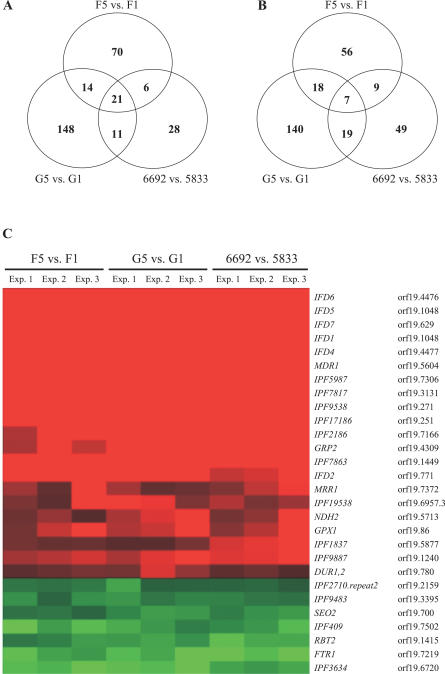
Identification of Genes that Are Differentially Expressed in MDR1 Overexpressing Clinical C. albicans Isolates(A, B) Venn Diagrams showing the number of genes that are upregulated (A) or downregulated (B) in the MDR1 overexpressing, drug-resistant isolates F5, G5, and 6692 as compared with their matched drug-susceptible isolates F1, G1, and 5833, respectively.(C) Heat map showing genes that are upregulated (red) or downregulated (green) in all three MDR1 overexpressing isolates. Results are from three independent experiments (Exp. 1 to Exp. 3) for each comparison. The genes are ordered according to their relative degree of up- and downregulation, as indicated by the brightness of the red and green fields (see Table S1 for details about the expression data). Gene names were taken from CandidaDB (http://genolist.pasteur.fr/CandidaDB), except for MDR1 and MRR1, and their orf19 names are given.